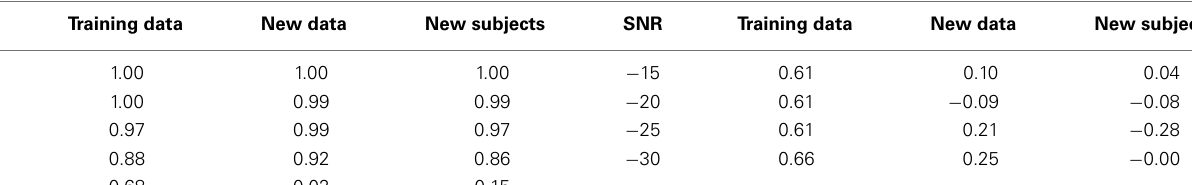
Table 2 | Correlation coefficients between the dynamical parameter b and the distance d from the hyperplane for different levels of noise. SNR